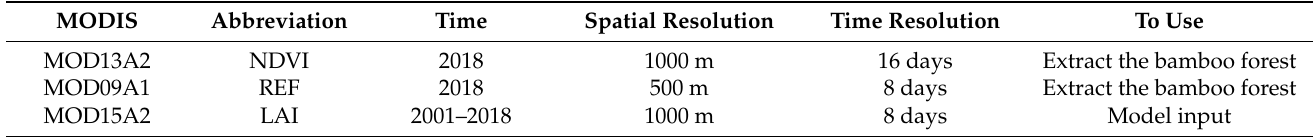
Table 1. MODIS data and